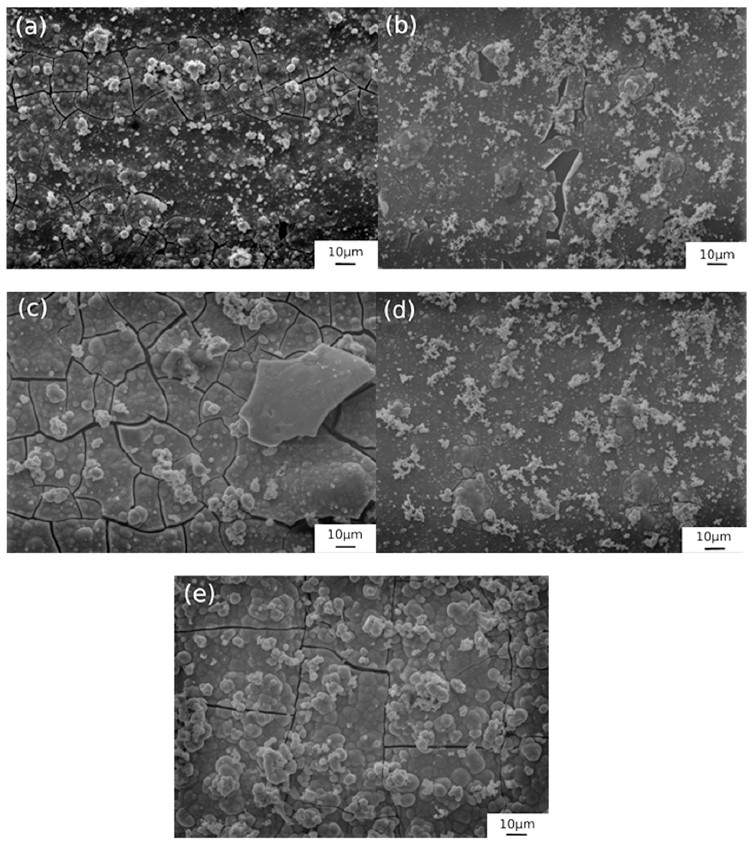
Figure 7. SEM images of the samples obtained with solution 1 at 50 °C with different soaking times: ( a ) 15 min, ( b ) 30 min, ( c ) 50 min, ( d ) 75 min, ( e ) 90 min.